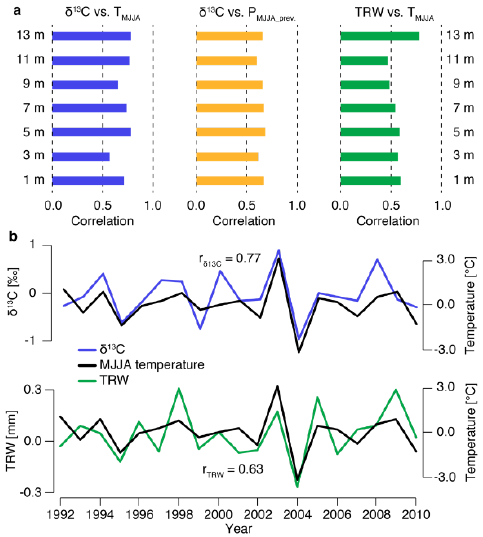
Figure 8. High frequency climate signals. ( a ) Pearson correlations δ 13 C disc mean curves (DCMs) against May–August (MJJA) mean temperatures (blue), δ 13 C DCMs against previous-year MJJA precipitation (yellow), and TRW DCMs against MJJA temperatures. Both the proxy and instrumental data were first-differenced. Correlations calculated over 1992 – 2010. ( b ) The δ 13 C mean tree curve (MTC) in blue and the TRW MTC in green plotted together with MJJA temperatures (black) from 1992 – 2010.